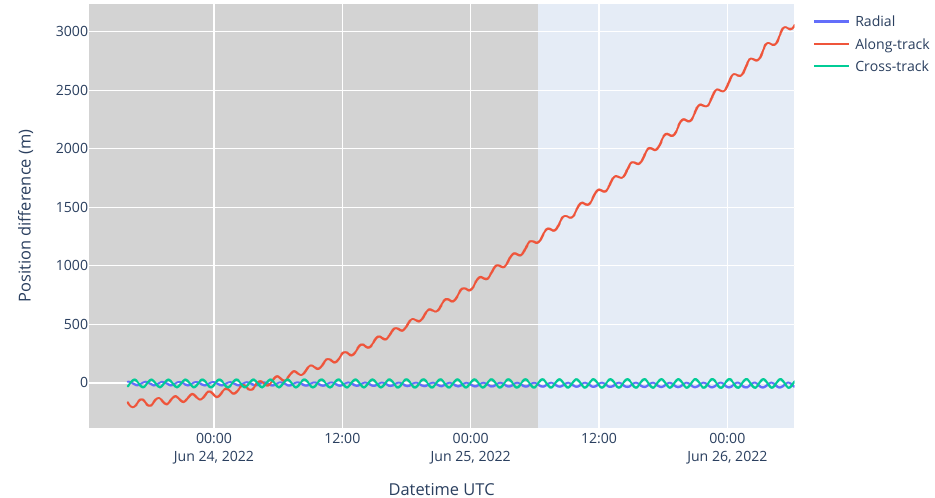
Figure 11. Position difference between the estimated orbit and the previous CPF prediction for an orbit determination on 25 June 2022 with a 42 h arc. The darker gray area on the left represents the orbit determination